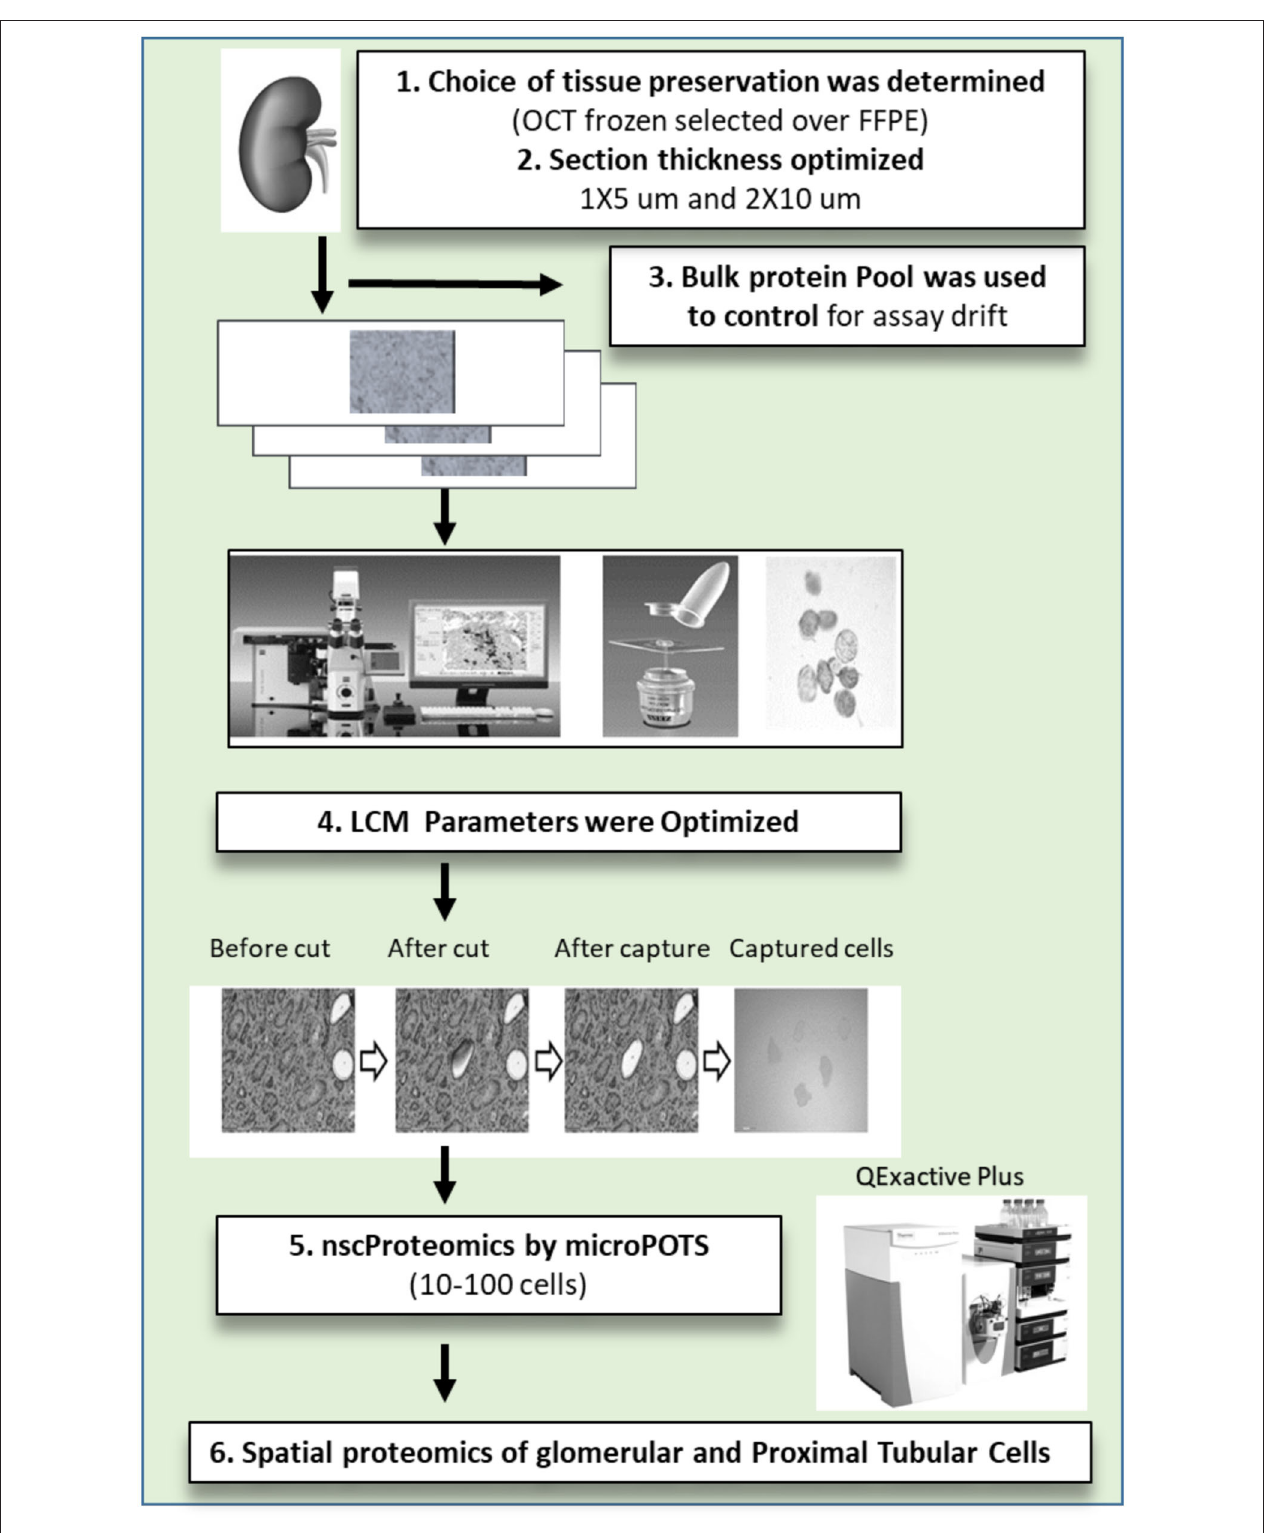
FIGURE 1 | The near single cell proteomics (nscProteomics) workflow optimized for processing human kidney tissues. The workflow includes the identification of optimal kidney tissue collection and storage, the quality controls for laser capture microdissection establishment of nscProteomics method for kidney cells.